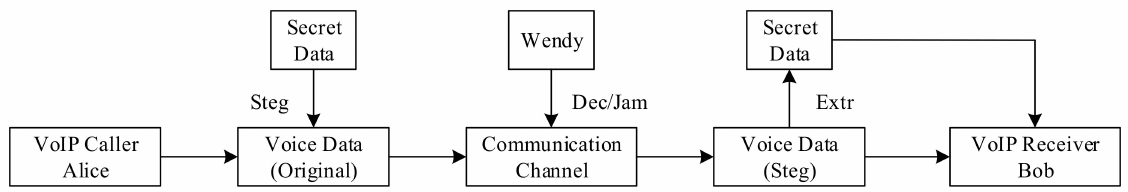
Figure 2. Steganography and confrontation model of VoIP